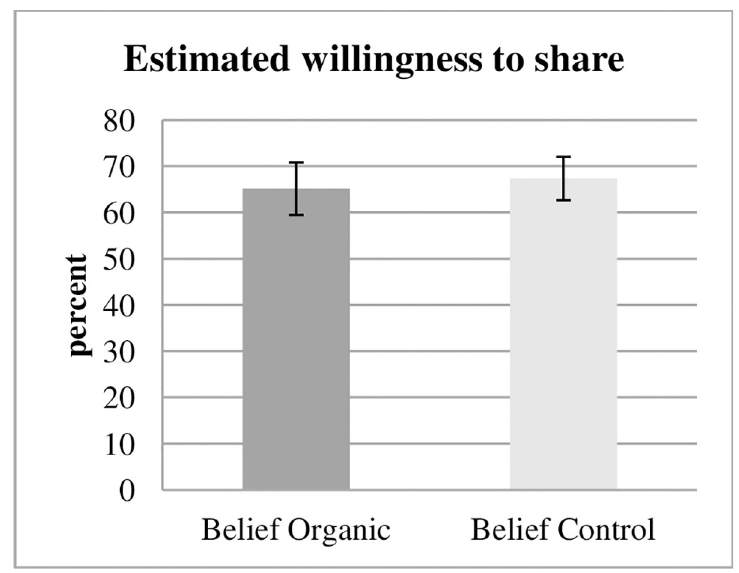
Fig 5. Estimated willingness to share belief treatments. Estimates from subjects in the Belief treatments for average willingness to share in the respective Product